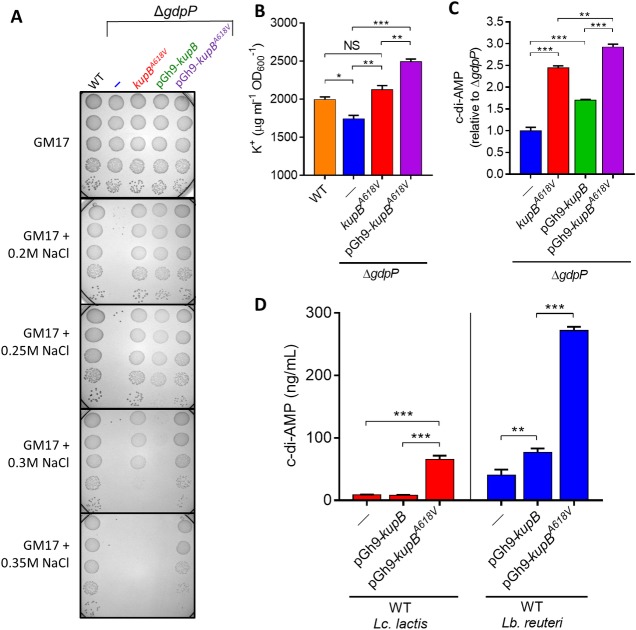
Constitutive KupB activity results in higher salt resistance and c-di-AMP levels in bacteria.(A) Overexpression of kupB and kupBA618V in Lc. lactis ΔgdpP enhances osmoresistance. Spots (5μl) are from log-phase cells diluted from 10−1 (top) to 10−5 (bottom). (B) K+ levels in WT Lc. lactis, ΔgdpP, ΔgdpPkupBA618V and ΔgdpP overexpressing kupBA618V. (C) C-di-AMP levels in ΔgdpP and ΔgdpPkupBA618V and ΔgdpP overexpressing kupB and kupBA618. (D) C-di-AMP levels in WT Lc. lactis and WT Lb. reuteri overexpressing kupB and kupBA618V. Data are the mean ± SEM from three independent biological replications. Significant results P < 0.001 (***), P < 0.01 (**) and P < 0.05 (*) are indicated (one-way ANOVA followed by Student’s t test).